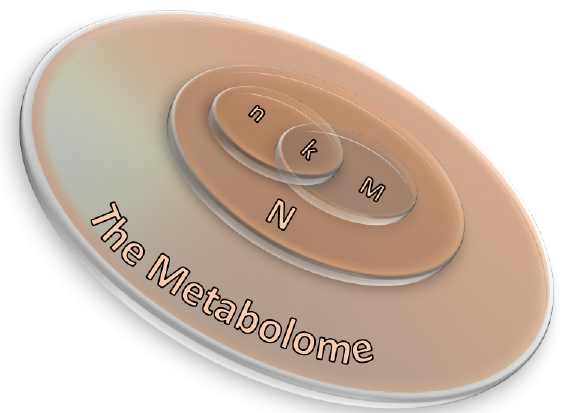
Figure 11. A 3D Venn diagram illustrating the relation between ORA parameters (Equation (6)) in which N corresponds to the number of background compounds, n is the number of the measured metabolites, M is the number of background metabolites mapping the i th pathway, and k represents the overlap between M and n